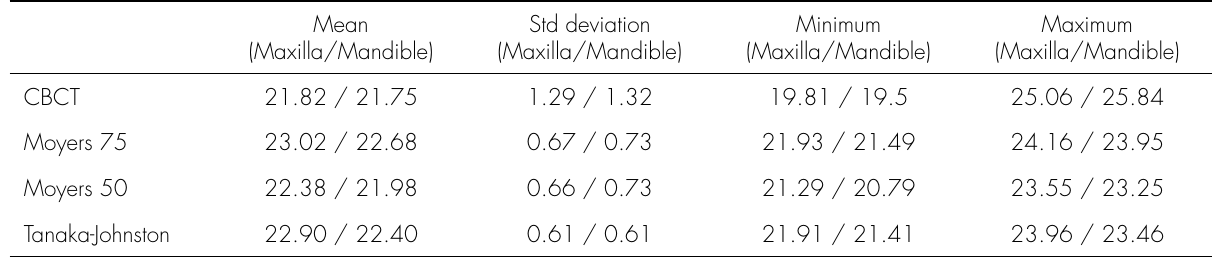
Table I. Maxilla and mandible descriptive statistics on SUCP values (mm) given by the cone beam computed tomography (CBCT), Moyers’ tables on percentiles 75 and 50, and Tanaka-Johnston’s models (N = 26 in all cases).